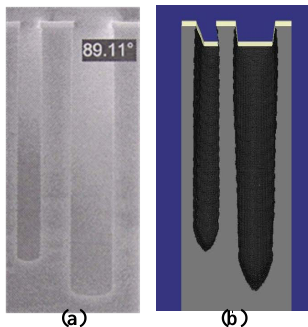
Figure 9. The SEM photography ( a ) and simulation result ( b ) showing lag effect.